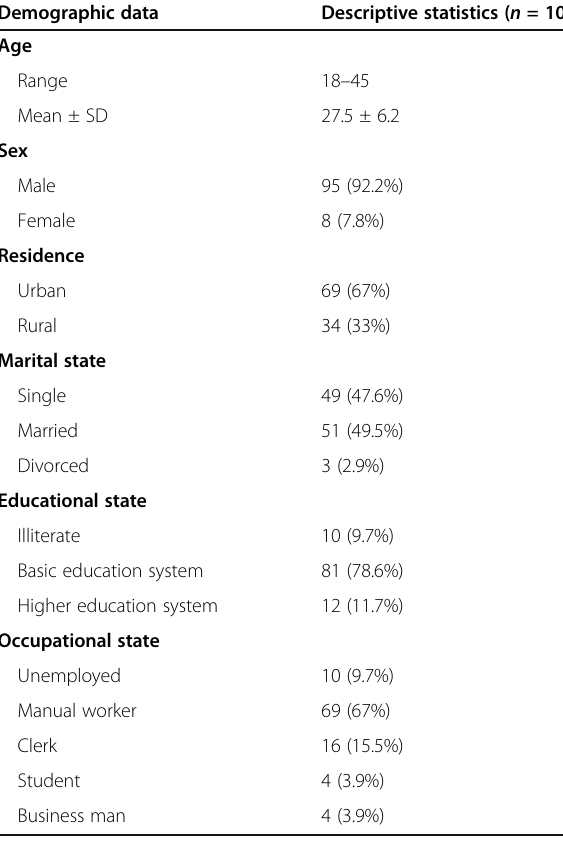
Table 1 Socio-demographic characteristics